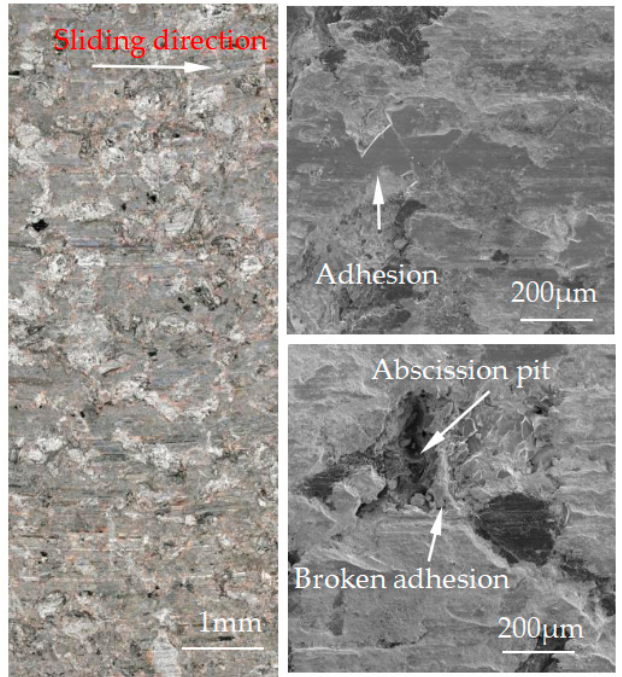
Figure 11. Surface morphology of the pad material after intermittent braking at an ambient temperature of − 30 °C.